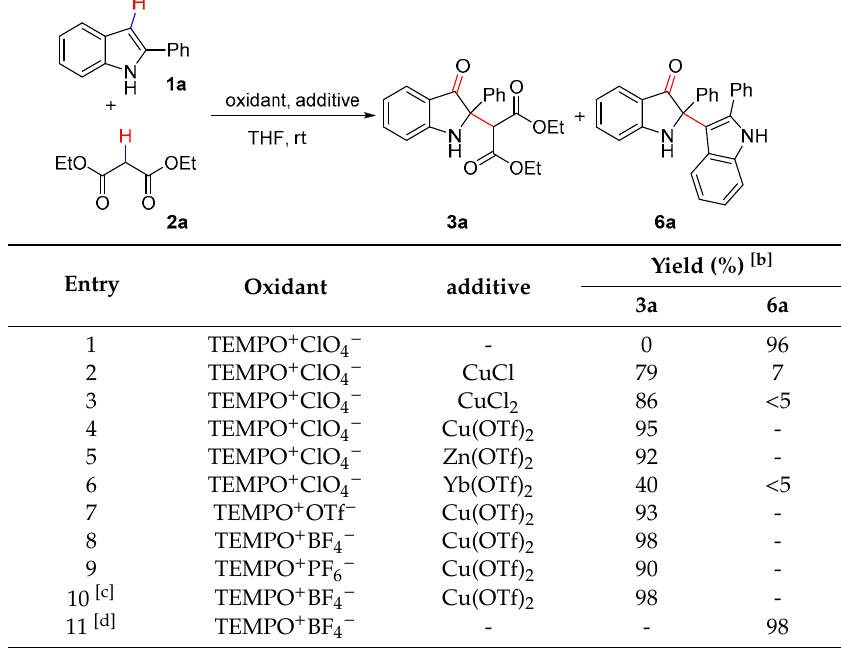
Table 1. Optimization of reaction conditions [a] .